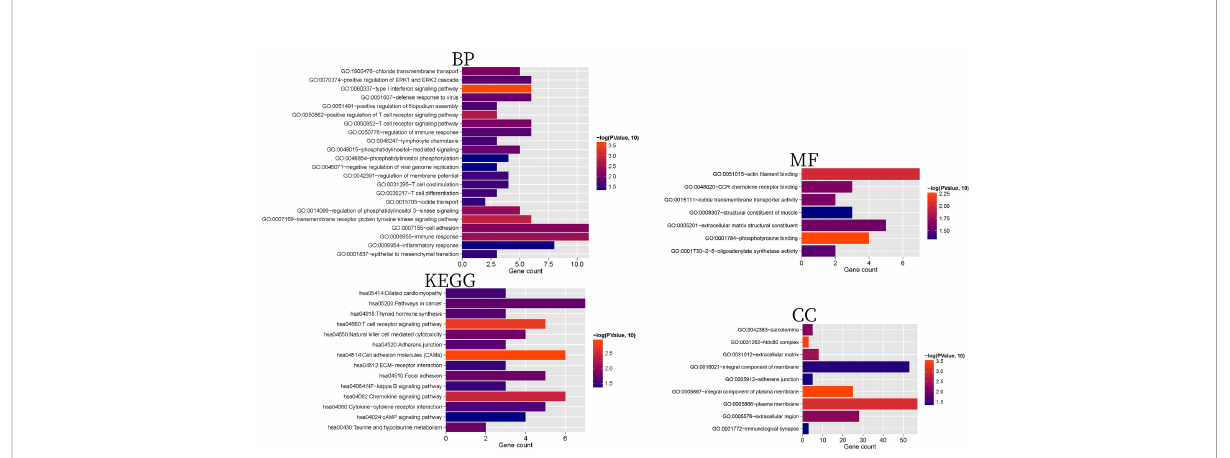
FIGURE 3 BP, CC, MF, and KEGG histograms related to 171 mRNAs with signi fi cant differential expression. The horizontal axis represents the number of genes, the vertical axis represents the signi fi cantly related items, and the color represents the correlation. The closer to red, the higher the signi fi